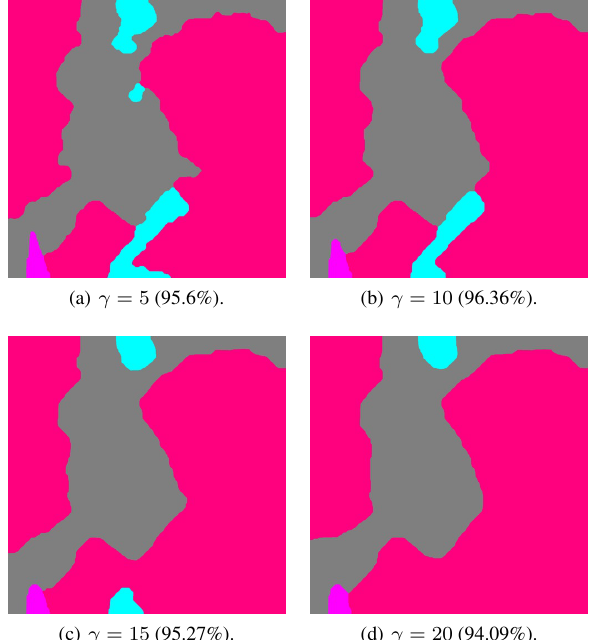
Figure 4. Results of the Exponential-features model with linear unary for different values of γ for Area 2, the overall accuracy is specified in brackets. Color codes: deciduous oaks , fir or spruce , chestnut , robinia